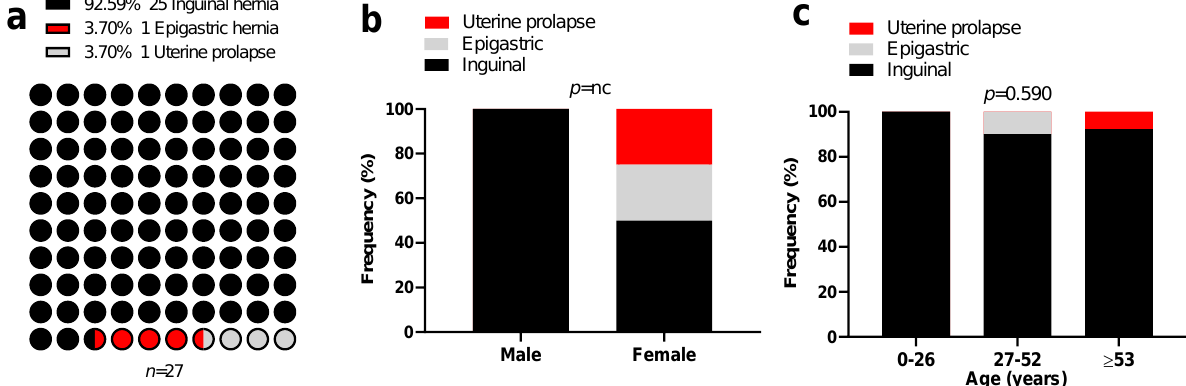
Figure 2. Frequency of the [a] various types of hernia, stratified by [b] gender and [c] age of the study subjects at Mankranso District Hospital, Ghana. Pearson Chi-Square and Fisher’s Exact tests were used appropriately to compare the differences in proportions of clinical characteristics between gender and age groups; nc: Not computed; p≤0.05 was considered significant.